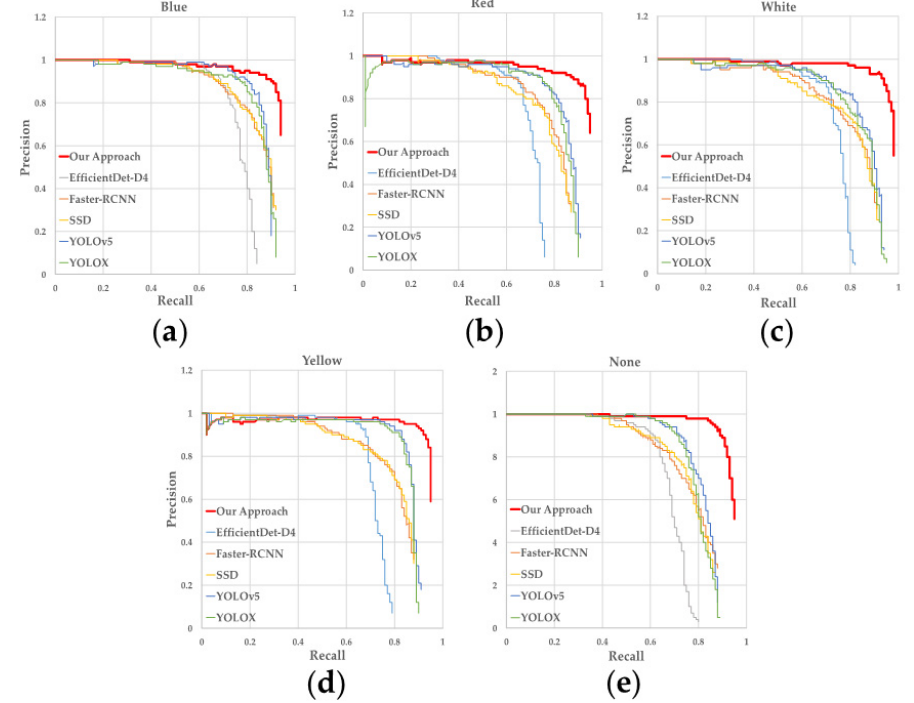
Figure 15. Precision × recall curves for each target category detection, ( a ) Blue, ( b ) Red, ( c ) White, ( d ) Yellow, ( e ) None. Table 6. Comparison of the proposed method with SSD, Faster-RCNN, YOLO series, and Effi- cientDet on the same dataset. An Interaction of Union (IoU) threshold of 0.5 is adopted here. Method